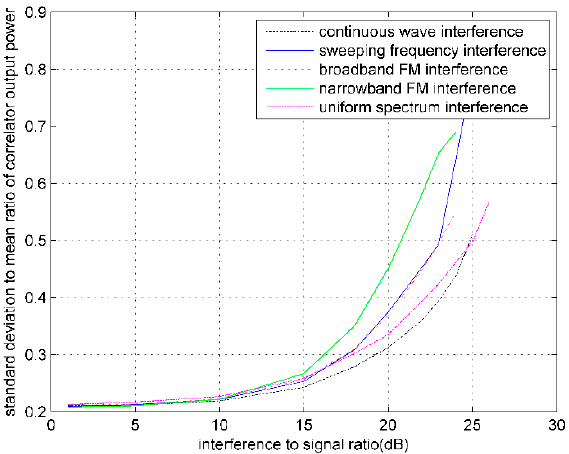
Figure 6. The variation curves of COP to COP mean ratio under different RFIs.